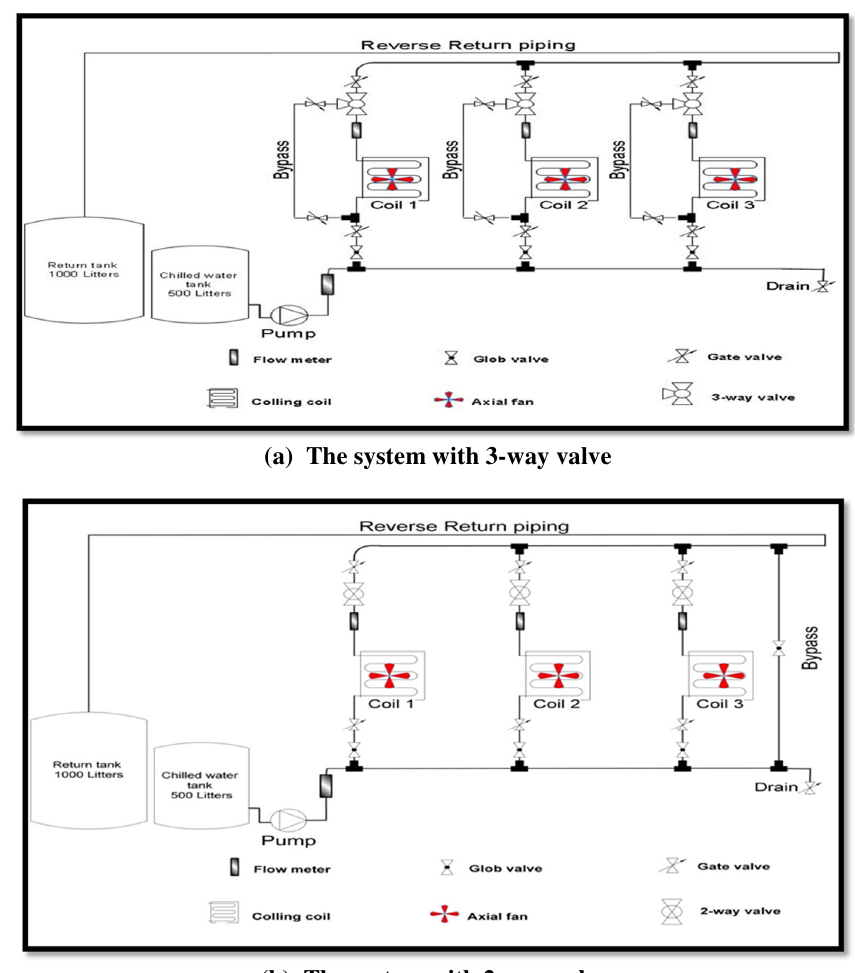
Fig. 1. a and b: Schematic diagram of the